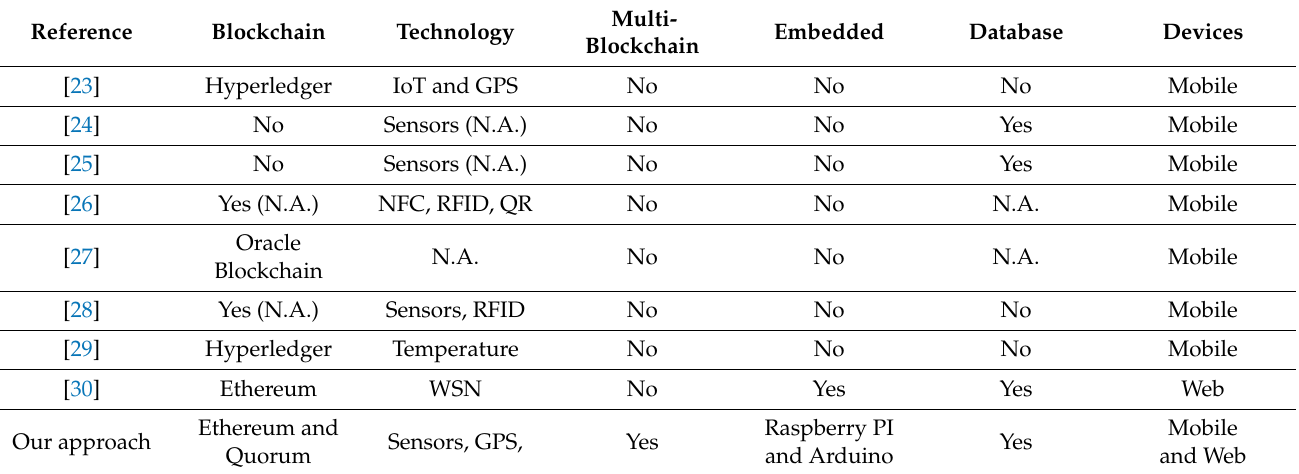
Table 2. Existing approach